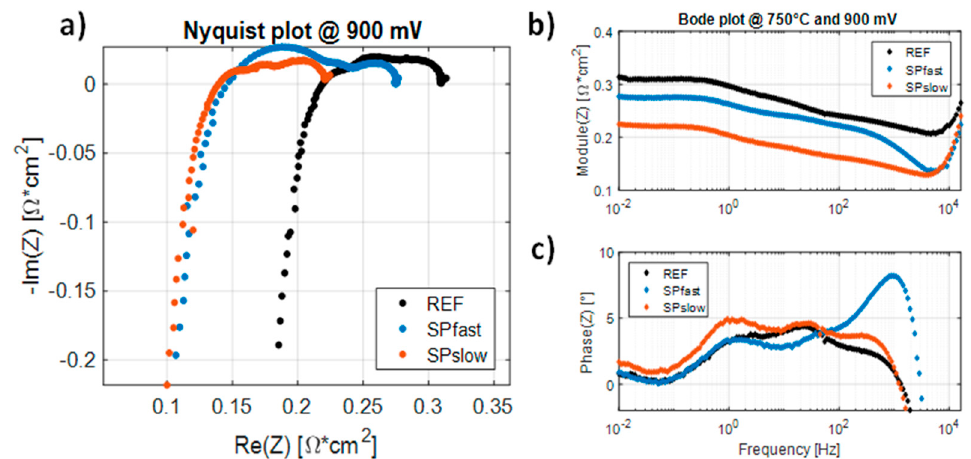
Figure 7. Nyquist ( a ) and Bode ( b , c ) plots of samples REF (black markers), SPfast (blue markers), and SPslow (red markers) measured at 750 °C and 900 mV.